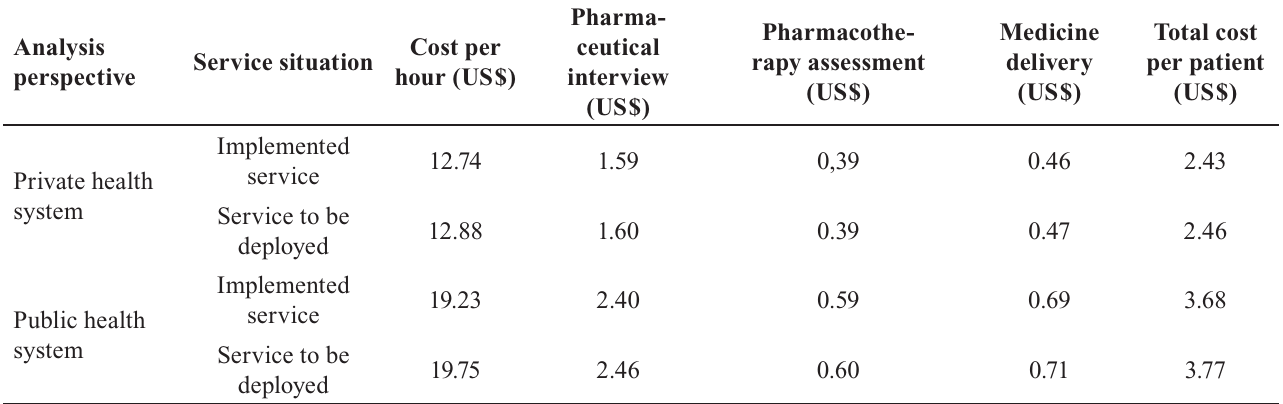
TABLE V – Costs of medicine dispensing service per perspective and service situation